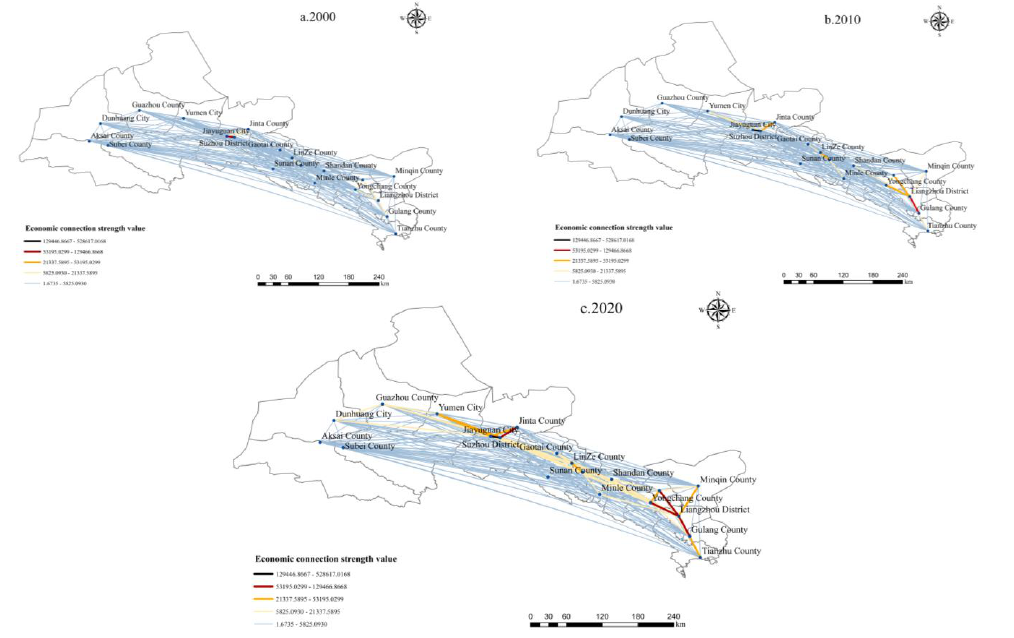
Figure 5. The evolution of the economic connection pattern of the Hexi Corridor urban agglomeration in 2000, 2010, and 2020.